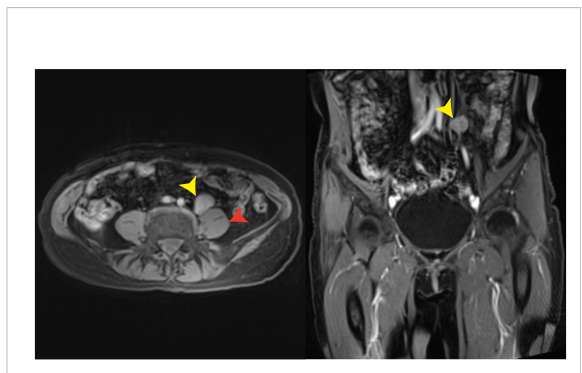
FIGURE 3 Pelvic MRI on 7 January 2022. A likely metastatic lymph node (yellow arrows) in the anterior area of the left psoas major (red arrow) and left of the common iliac artery was found 15 months after the administration of